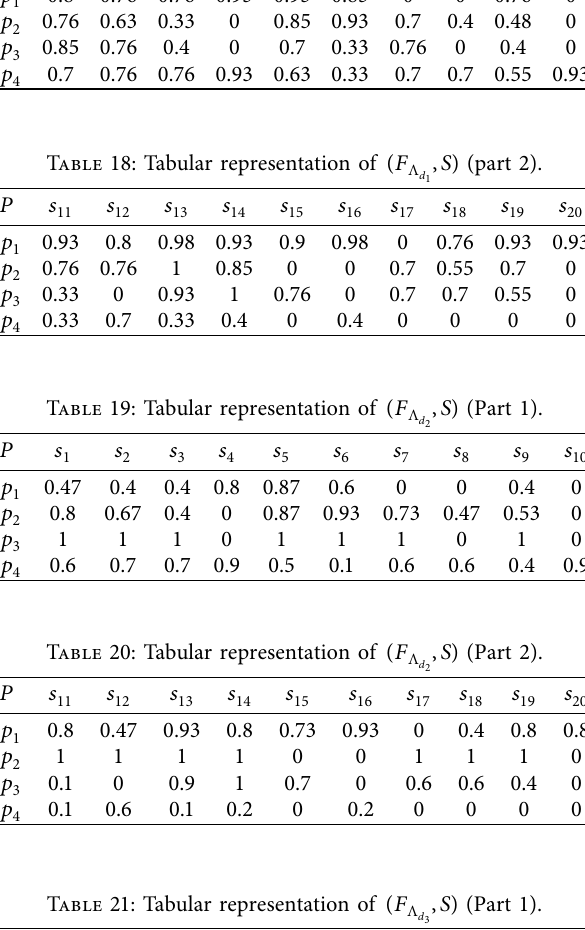
Table 21: Tabular representation of ( F